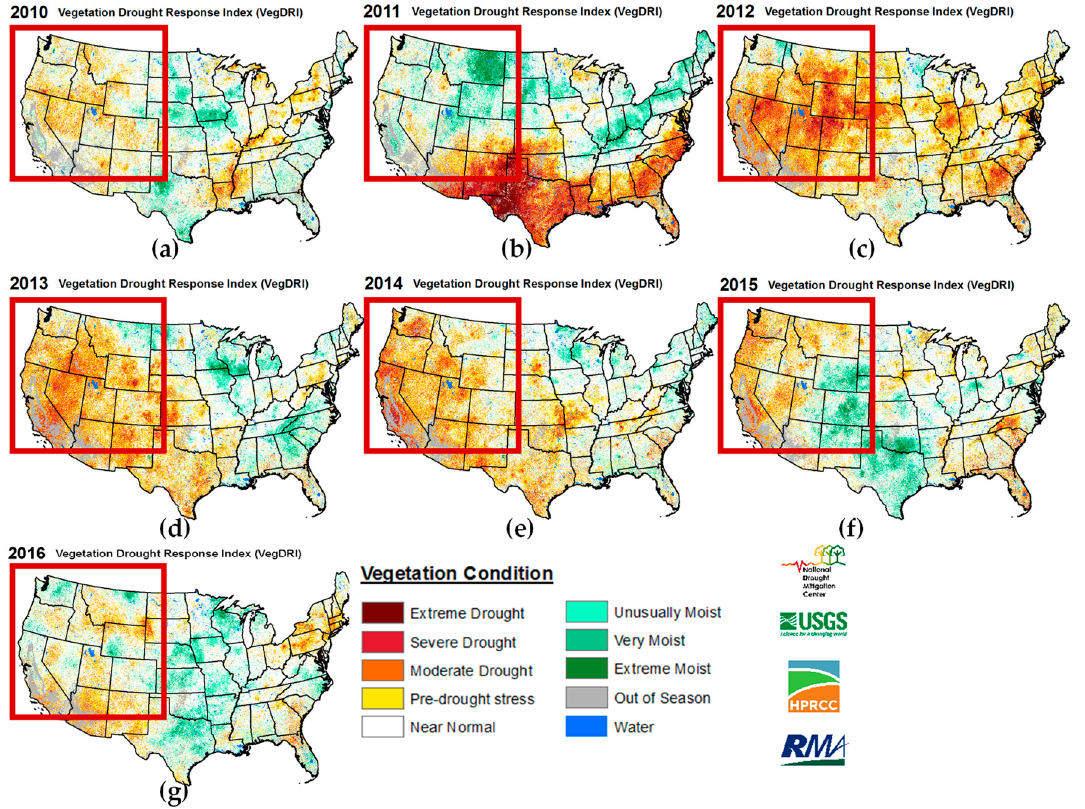
Figure 11. Vegetation Drought Index (VegDRI) distribution map for 2010 to 2016. Taken from https://www.drought.gov.